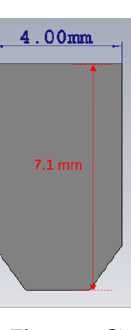
Figure 5. Size of the